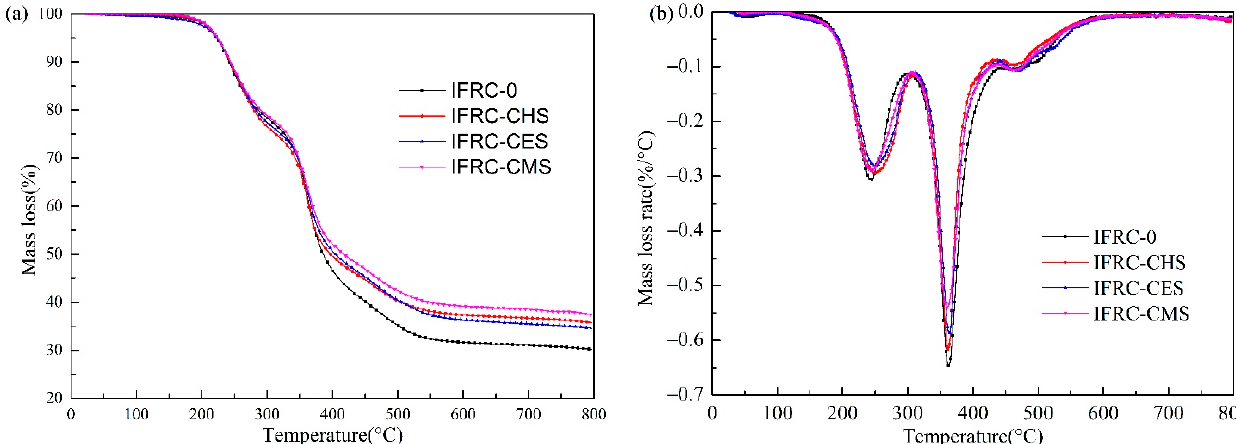
Figure 10. TG ( a ) and DTG ( b ) curves of IFRCs under nitrogen atmosphere. Table 5. Thermal data of the IFRCs under nitrogen atmosphere.